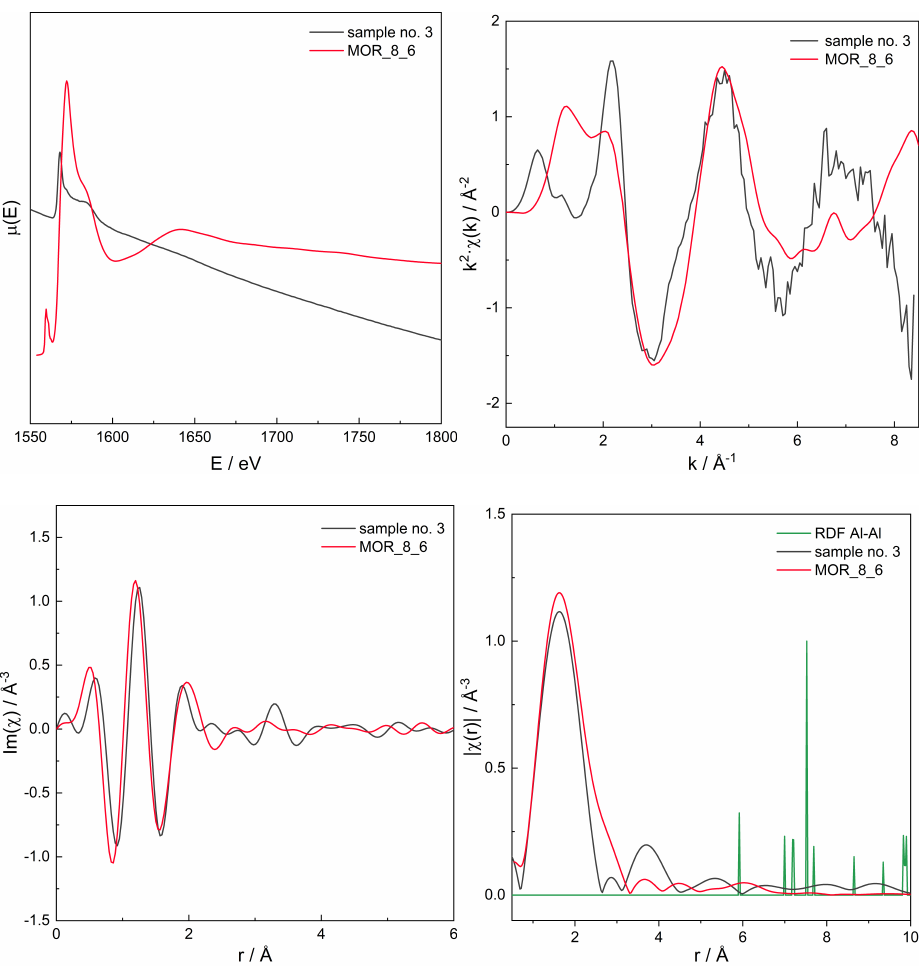
Figure 9. Spectrum of µ ( E ) ( upper left panel ), k 2 χ ( k ) ( upper right ), (cid:61) χ ( r ) ( lower left ), and | χ ( r ) | ( lower right ) for sample no. 3 (MOR of Si/Al = 8) and simulation for computational model labelled MOR_8_6. Matching RMS = 0.0529. The simulation model characterised by Al–Al distances of: 5.9, 7.0, 7.5, 8.5, and 9.9